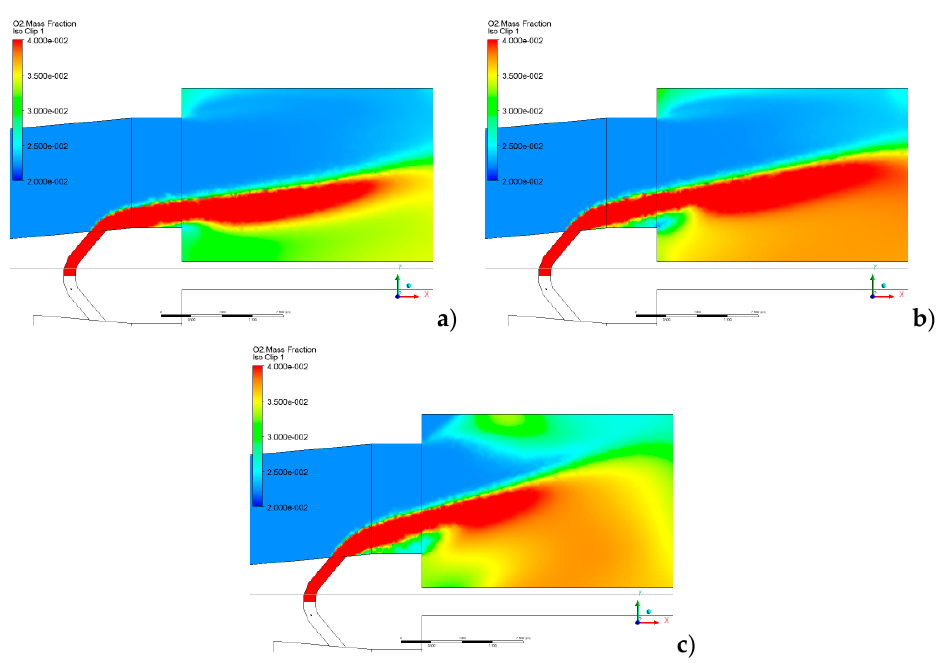
Figure 19. O 2 mass fraction at the top chamber cons massflow 16 m 3 / h—( a ) 50 m 3 / h ( b ) 60 m 3 / h ( c ) 80 m 3 / h.